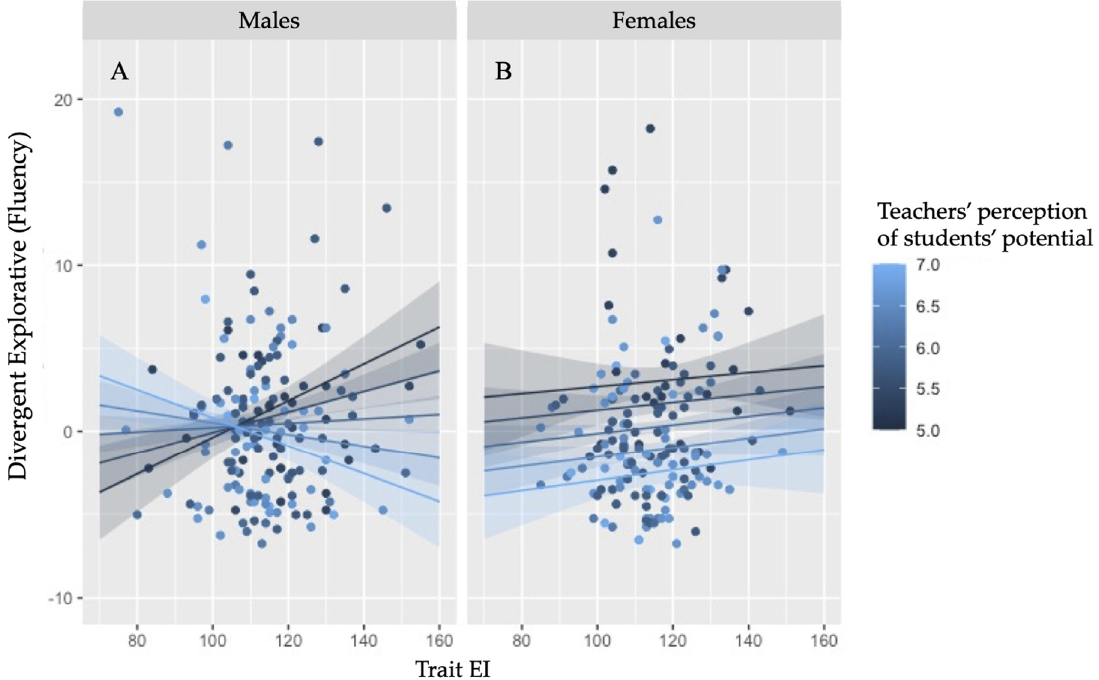
Figure 3. Interaction of trait emotional intelligence and teachers’ perception of students’ potential in predicting EPoC divergent thinking as a function of gender (males ( A ); females ( B